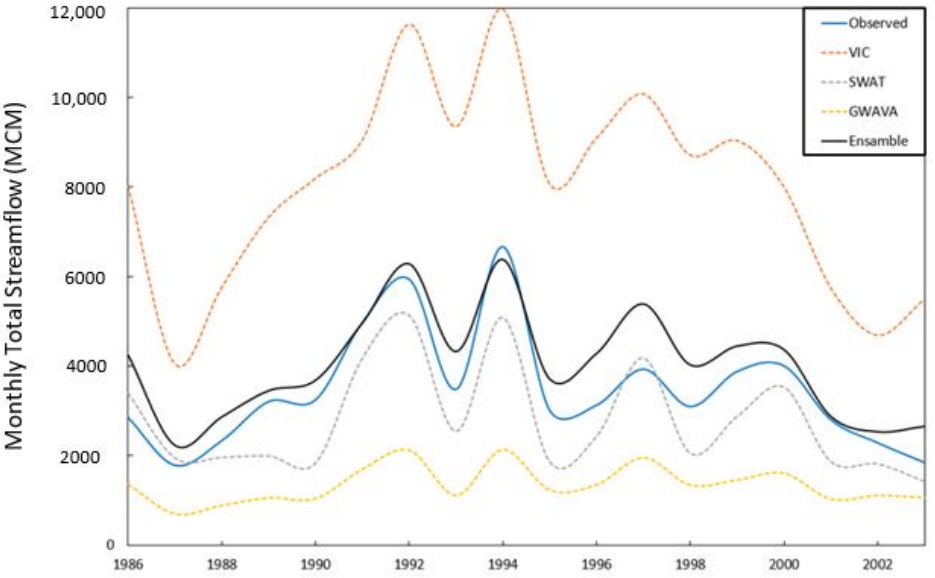
Figure 3. The monthly total observed streamflow and streamflow simulated by VIC, SWAT, GWAVA and the ensemble at KRS inflow.